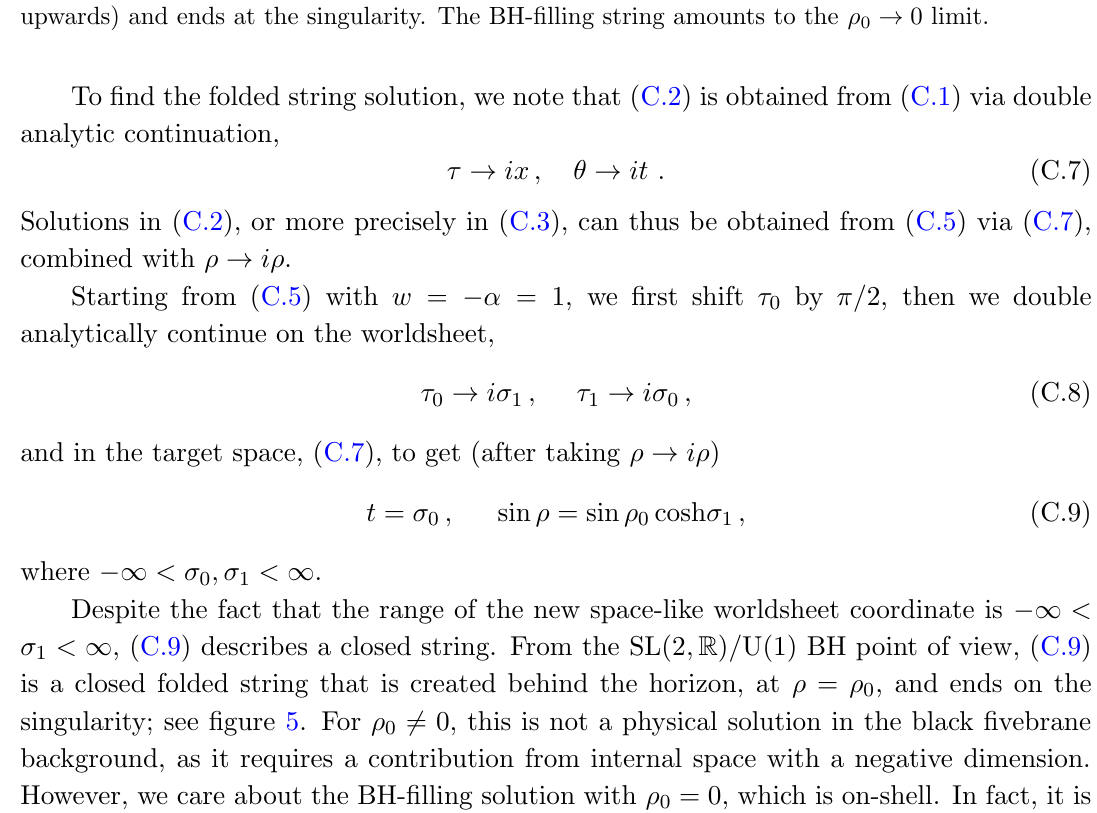
Figure 5 . The solution (C.9), reduced on the BH geometry: both (cid:27) 0 and (cid:27) 1 run from (cid:0)1 to 1 . They do so in a way that at (cid:26) = (cid:26) 0 (at the bottom of the shaded regime) and t = i(cid:12)= 4 (namely, at t = 0 in the BH interior), a closed folded string is created, propagates (in global time, namely, upwards) and ends at the singularity. The BH-(cid:12)lling string amounts to the (cid:26) 0 ! 0